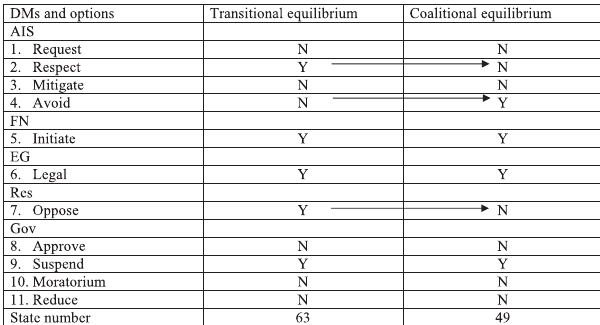
transitional equilibrium to a coalitional